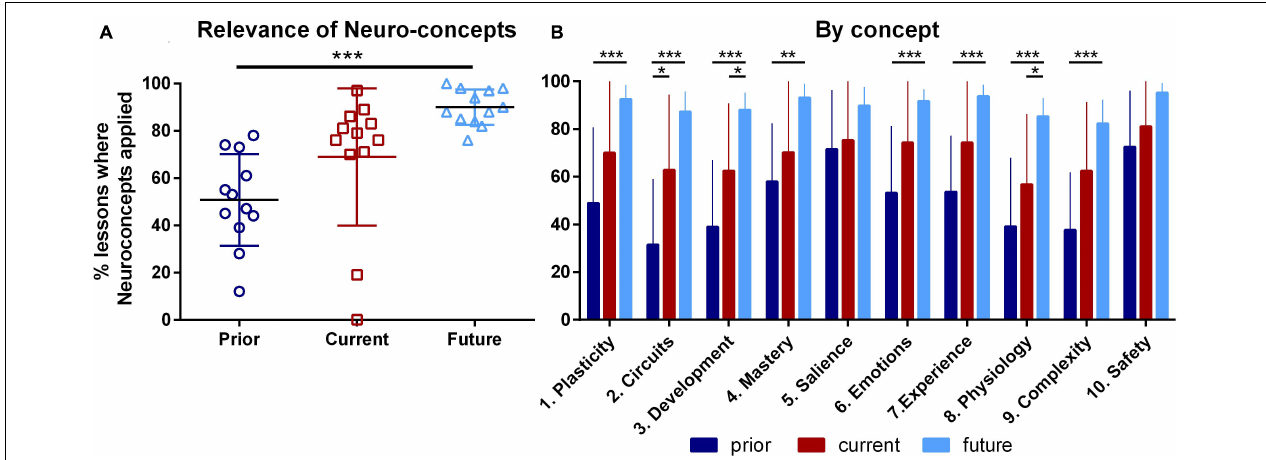
FIGURE 1 | Teachers ratings of the direct applicability of 10 neuroconcepts to their teaching prior to the Neuroscience for Educators course, in the current academic year and in future lessons. (A) Brackets represent mean ± SD for each time point. Individual data points represent different teachers, mean ± SD summed across all ENCs. The two lowest current responses were from teachers holding administrative positions, representing their limited exposure to students. Significance shown represents Bonferroni post-tests following the significant main effect of time ( p < 0.001, Cohen’s d = 16.1). (B) Bars represent mean ± SD for each individual ENC, summed across all teachers. Significance shown represents Bonferroni post-tests following individual one-way ANOVAs for each ENC ( p -values < 0.001, 0.000, 0.000, 0.002, 0.14, 0.000, 0.001, 0.000, 0.000, and 0.054, respectively, for ENCs 1 to 10); *, **, *** represent p < 0.05, 0.01, 0.001, respectively; N = 12 teachers.